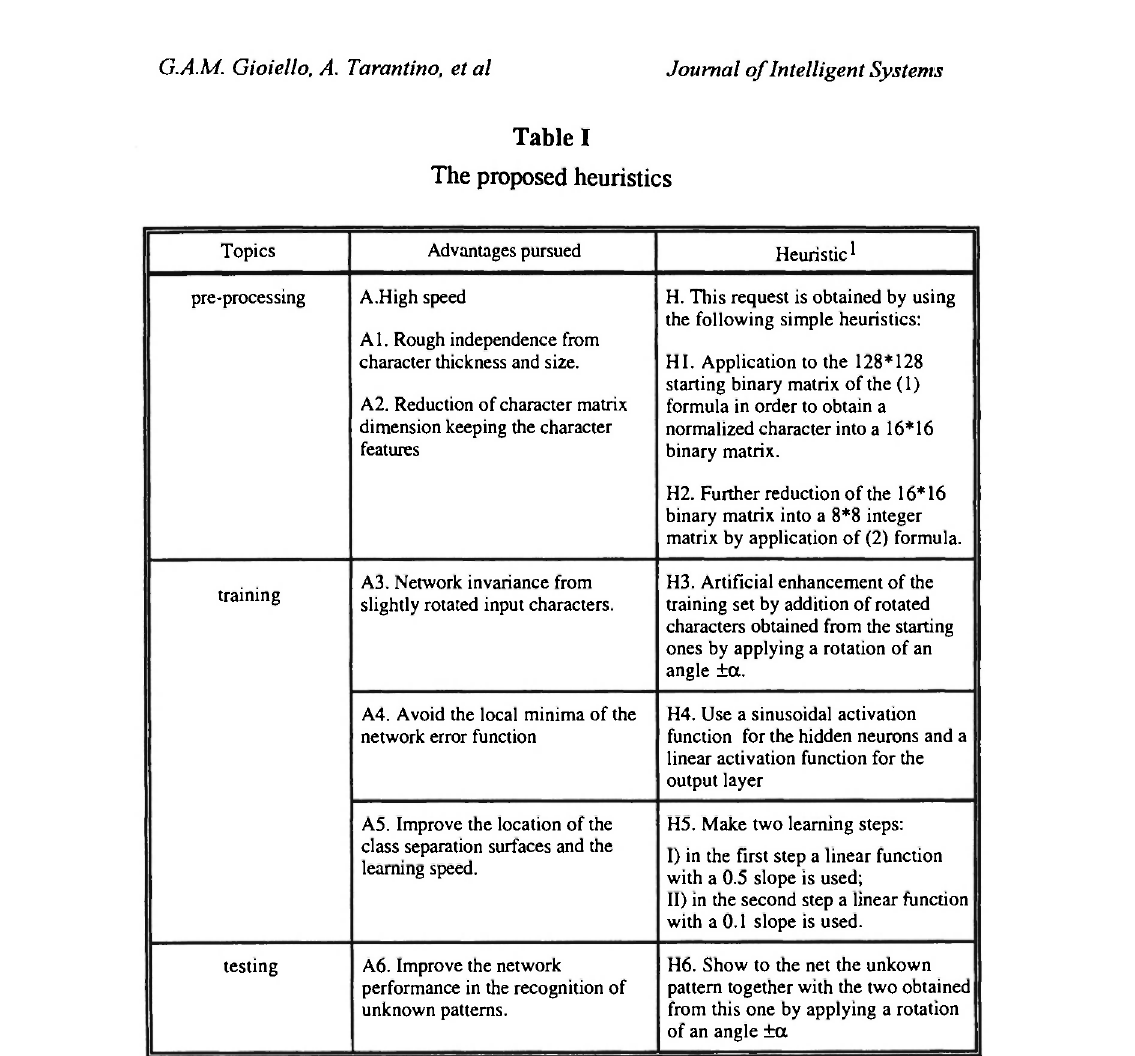
MLP's performance for uppercase